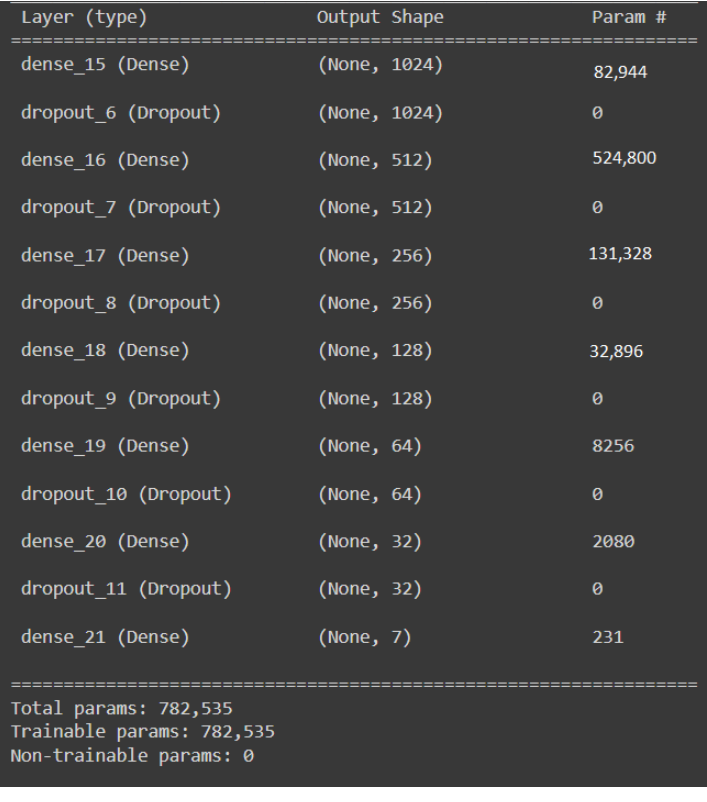
Figure 2. Architecture of the DNN